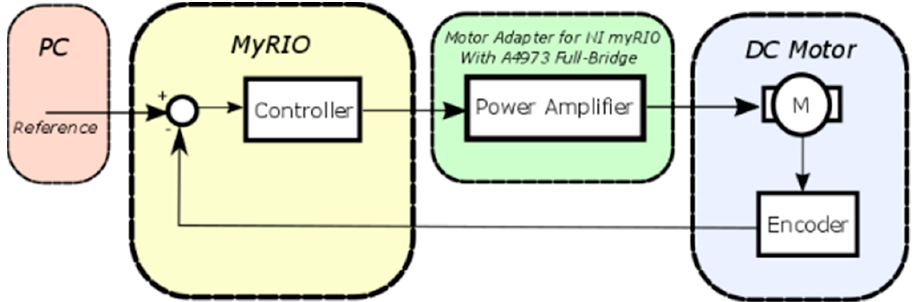
Figure 7. Block diagram of the experimental setup.